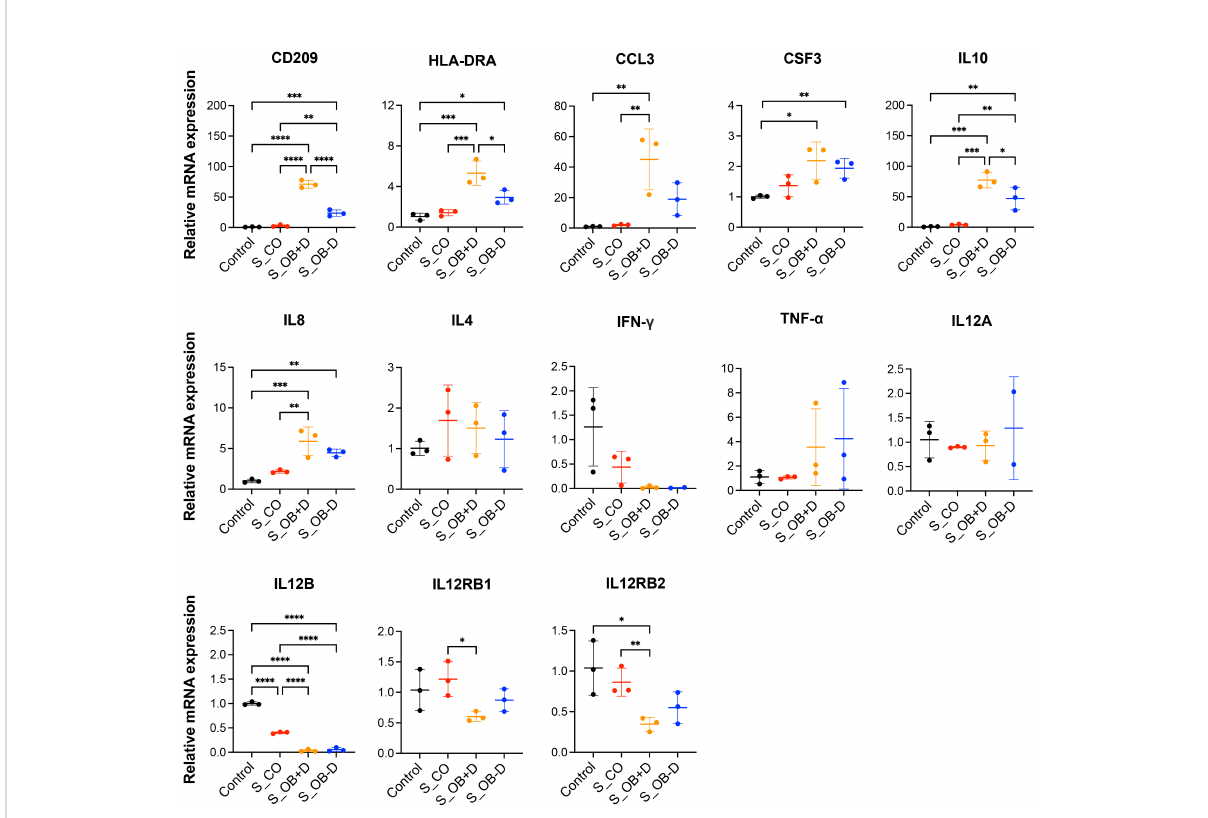
FIGURE 6 Effects of JPC secretomes on gene expression levels of maturated MoDCs. The relative gene expression levels of DCs generated by indicated treatments (control or after supplementation with 5-fold concentrated JPC secretomes) were presented as 2 - DD Ct . Mean ± SD values of three independent experiments were calculated and compared using one-way ANOVA and Tuckey ’ s multiple comparison tests (n=3, *p < 0.05, **p < 0.01, ***p < 0.001, ****p < 0.0001).